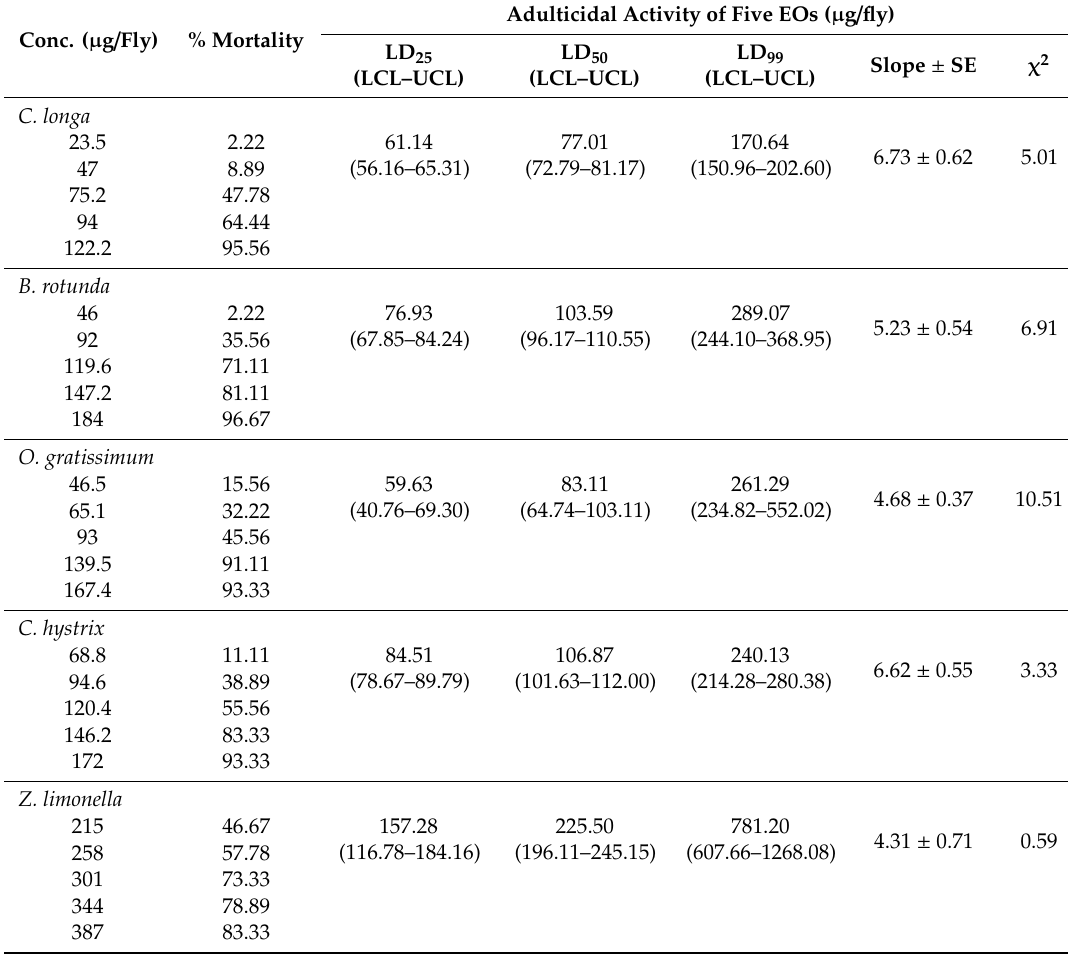
Table 4. Adulticidal activity of five EOs against M.